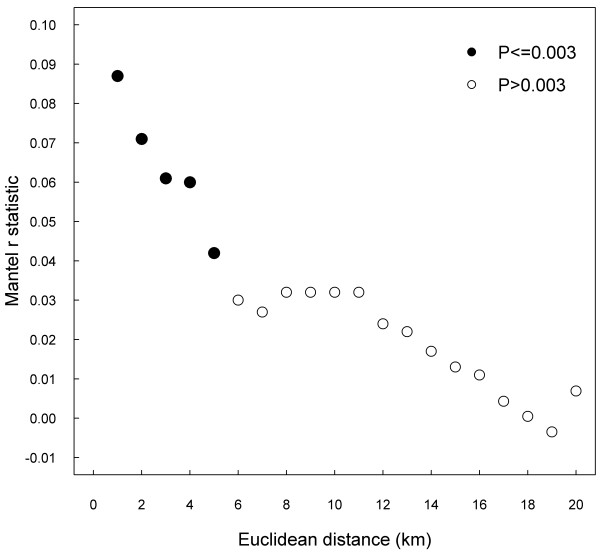
Correlogram showing Mantel r statistic computed on binary matrices of genetic (≥98%, <98% homology) and Euclidean distances for different thresholds (km). Results from 7381 different pairwise combinations of 122 PRRSV ORF5 sequences. Dark dots indicate significant correlation (P ≤0.003) after 9999 permutations of matrices.